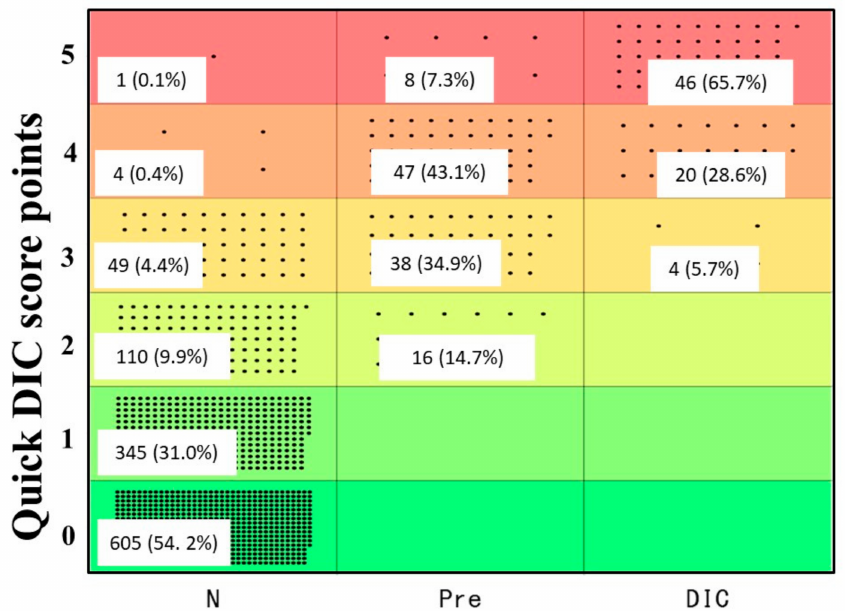
Figure 2. Quick DIC score in patients with non-DIC, pre-DIC, or DIC. DIC, disseminated intravascu- lar coagulation.